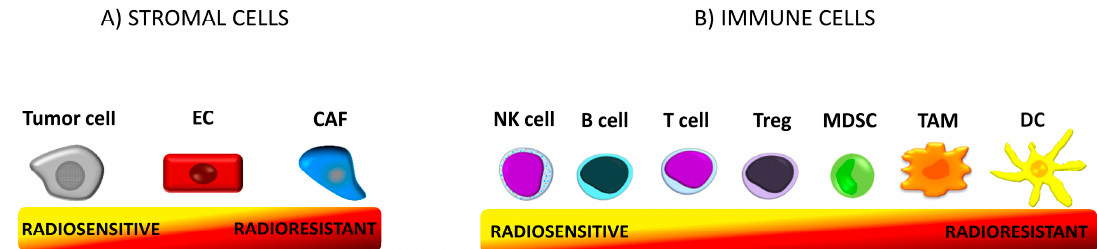
Figure 1. Tumor microenvironment (TME). TME is a functional and structural niche where tumor progression occurs. It consists of cellular and molecular (extracellular matrix, cytokines, chemokines, and other molecules) components. The microenvironment is composed of tumor stromal cells (cancer-associated fibroblast (CAFs), mesenchymal stromal cells (MSCs), endothelial cells (ECs), pericytes) and immune cells (T cells, B cells, natural killer (NK) cells, dendritic cells (DCs), tumor-associated macrophages (TAMs), tumor-associated neutrophils (TANs), myeloid-derived suppressor cells (MDSCs)) [6]. The cells differ in radiosensitivity. The term “radiosensitivity” means the relative susceptibility of cells to radiotherapy (RT)-induced irreversible damage such as chromosomal instability and cell death [37]. ( A ) Proliferating tumor cells are sensitive to irradiation (IR) [37]. Endothelial cells are resistant to doses up to 10Gy. CAFs are the most resistant stromal cells. ( B ) Within the cells of the immune system regulatory T cells (Tregs) are more radioresistant than any other population of T cells [38] and B cells [39]. NK cells and B lymphocytes are the most radiosensitive immune cells, while DCs are the most resistant [40].